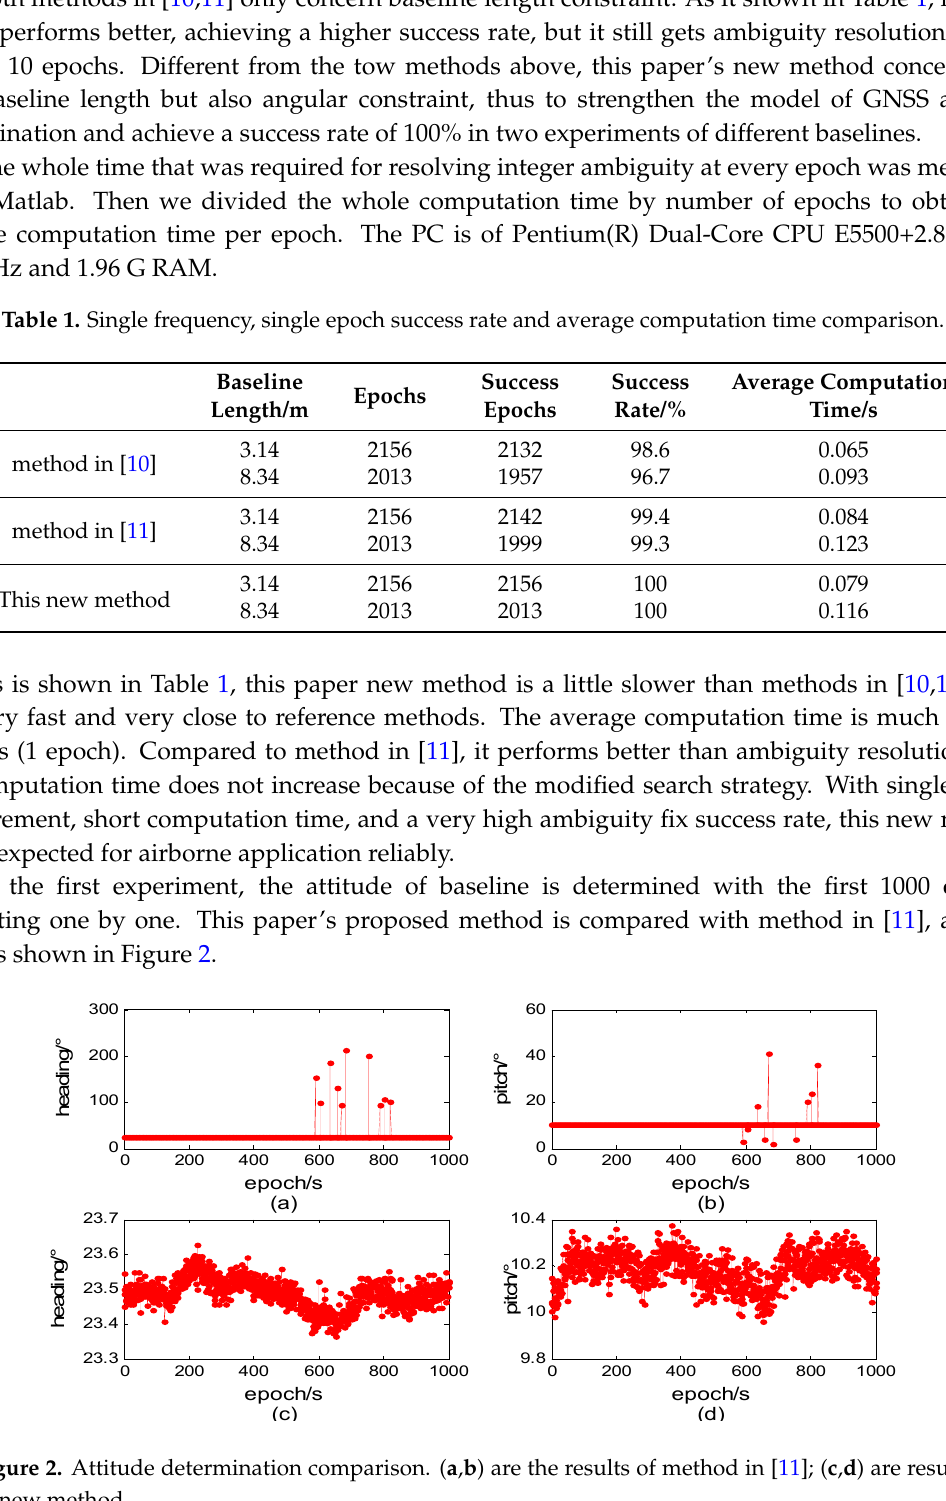
Table 1. Single frequency, single epoch success rate and average computation time comparison.